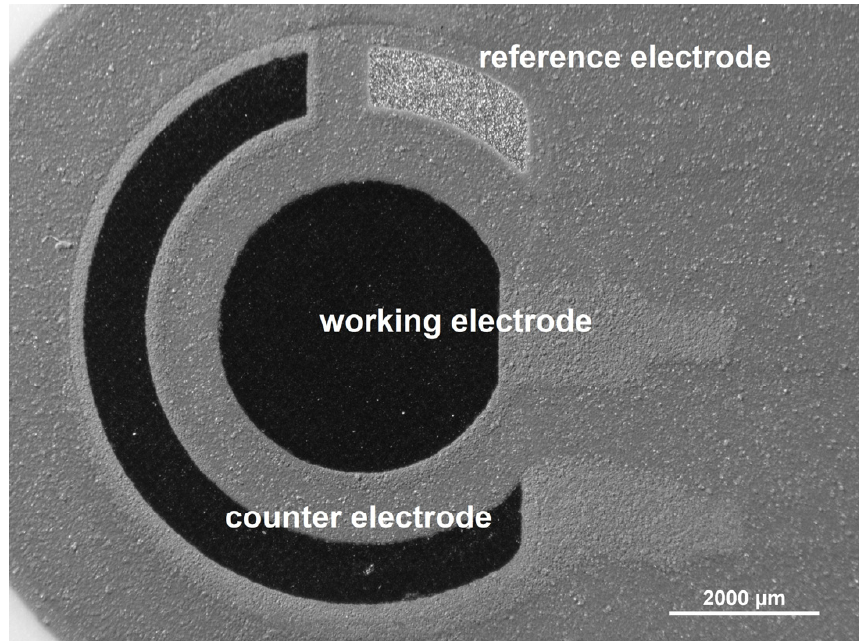
Figure 1. Optical microscopic image of screen-printed carbon electrode (SPCE, Metrohm DropSens, Oviedo, Spain).